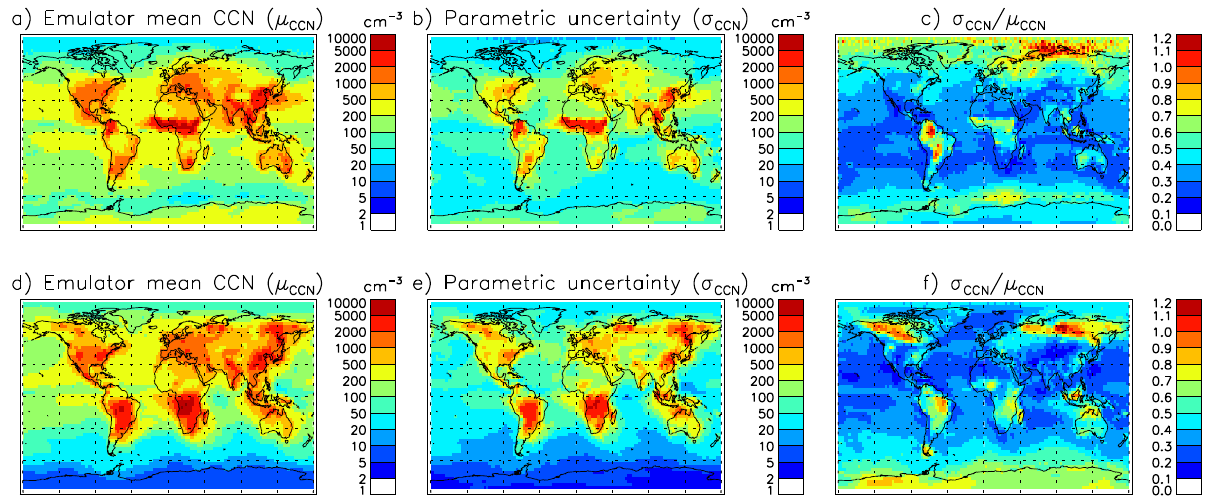
Fig. 5. Global fields of CCN concentration and associated uncertainty on the 915hPa model level. Left column ( a and d ), mean CCN ( µ CCN ) predicted by the emulators for January and July. Middle column ( b and e ), uncertainty in CCN (defined as the emulator standard deviation σ CCN due to the uncertain parameters). Right column ( c and f ), coefficient of variation ( σ CCN / µ CCN in each grid